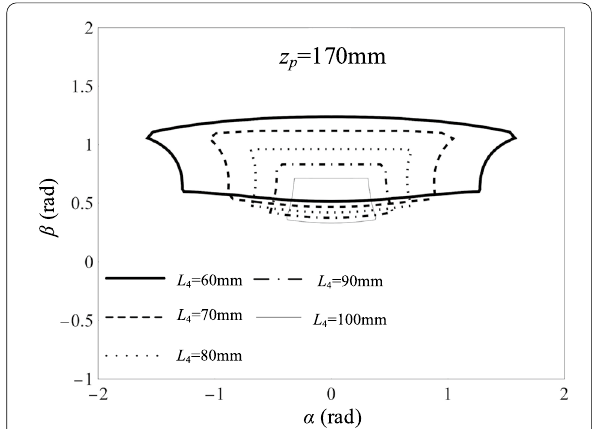
Figure 16 The image of the singular position of the mechanism when z p 170 mm =